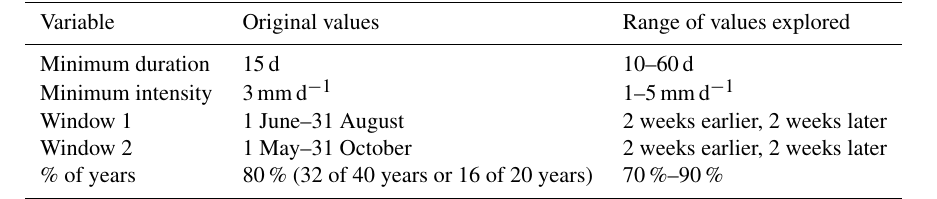
Table 1. Variable values for key components of the MSD definition.